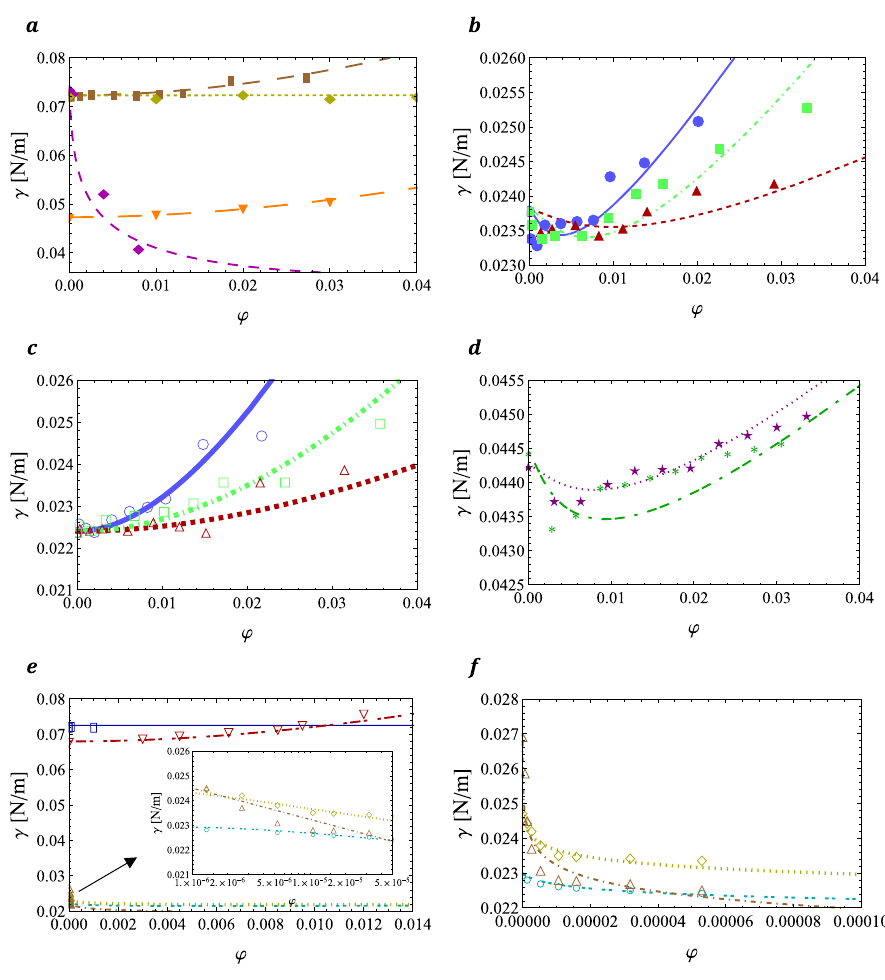
Fig. 3 Modelled surface tension as a function of the volume fraction of nanoparticle dispersions, compared to experimental data 6,9 – 11,19,38,47,48 . a Al 2 O 3 -W (